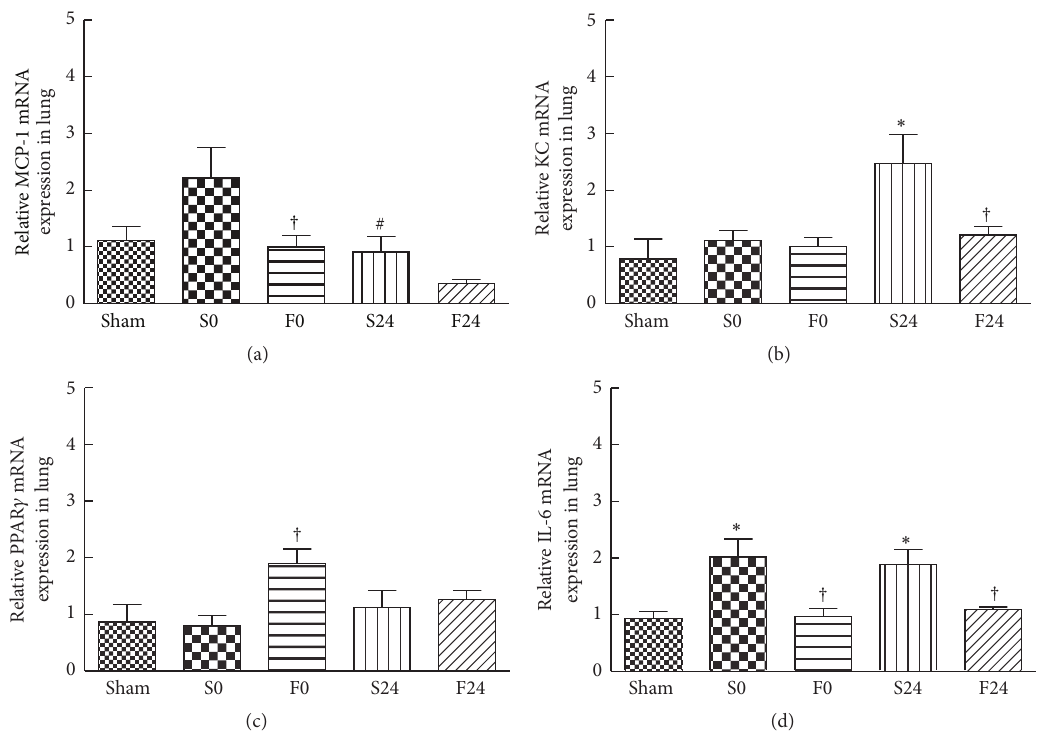
Figure 4: Expression of (a) monocyte chemotactic protein-1 (MCP-1), (b) keratinocyte-derived chemokine (KC), (c) peroxisome proliferator- activated receptor- 𝛾 (PPAR- 𝛾 ),and (d)interleukin-6(IL-6)mRNAsin lungtissues.Data arepresentedas themean ± SEM( 𝑛 = 8 ). Differences among groups were analyzed by one-way ANOVA with Tukey’s post hoc test. ∗ Different from the sham group. † Different from the saline (S) group at the same time point. # Different from other time points in the same group ( 𝑝 < 0.05